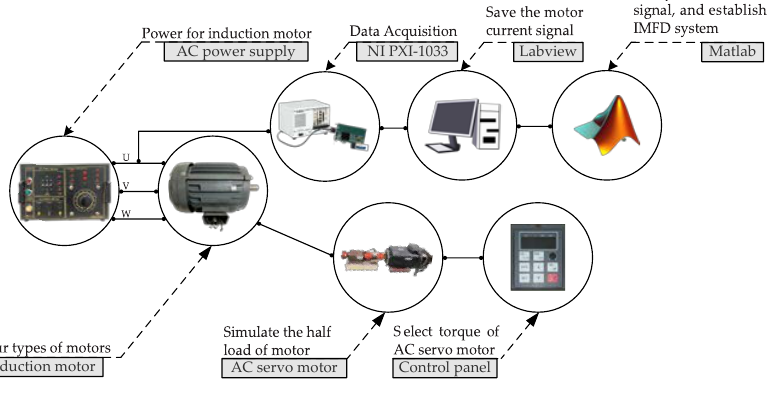
Figure 2. Equipment layout.